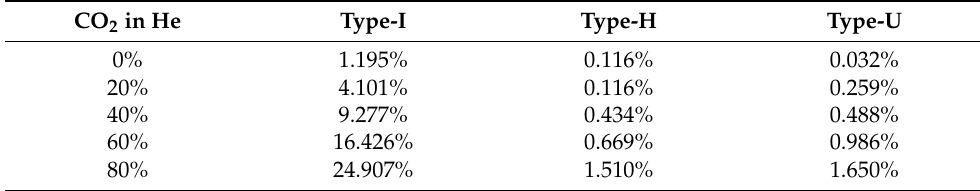
Table 3. Test results: the normalized flow-rate interference on the output